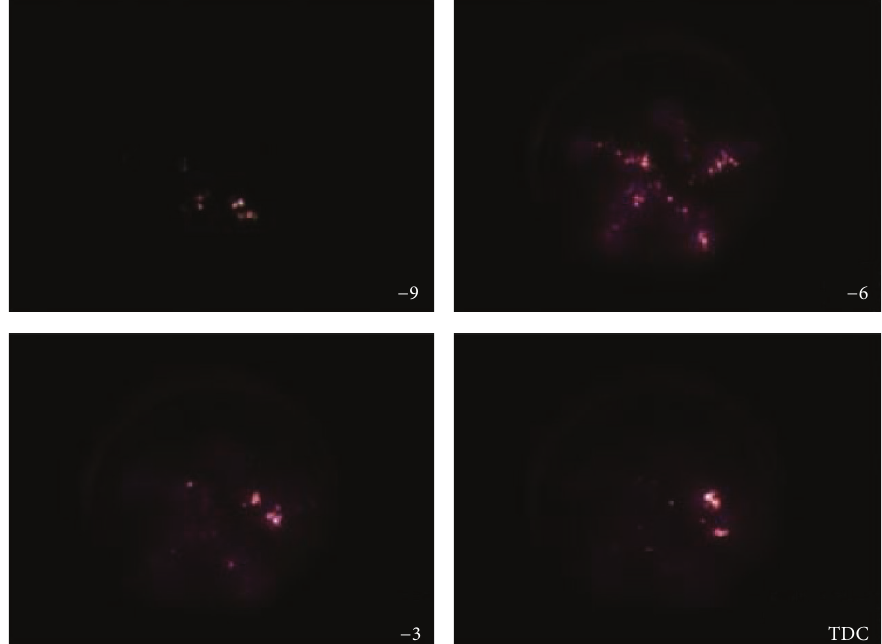
Figure 11: Direct imaging of PCCI combustion with two-stage injection strategy; main injection timing = − 200 ∘ CA ATDC, main injection quantity = 10mm 3 , second injection quantity = 1.5 mm 3 , injection pressure = 120 MPa, and injection angle = 150 ∘